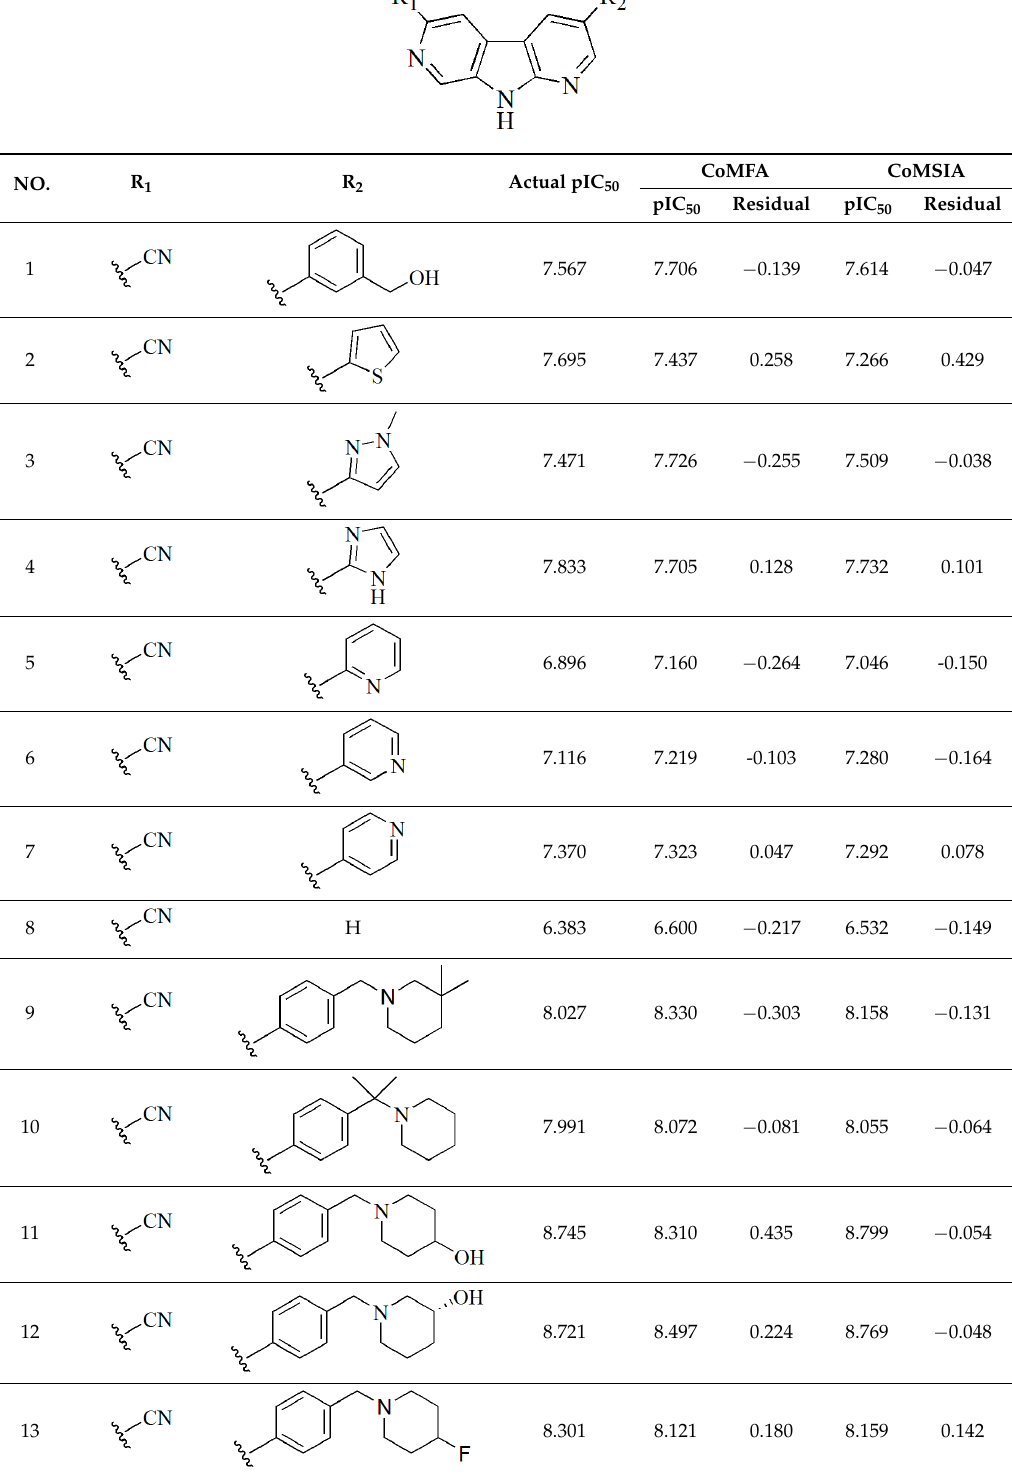
Table 1. Chemical structural formulas of all structures. Statistical parameters of the actual and predicted bioactivity by CoMFA and CoMSIA, as well as the residual between the actual and predicted pIC 50 values. All the aligned molecular dataset used for the 3D QSAR studies were shown in Table S1 in the supplementary materials